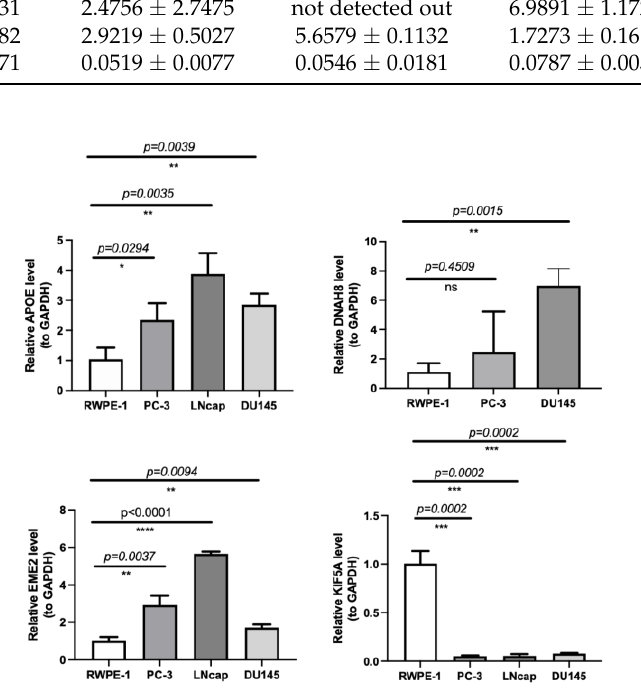
Figure 7. mRNA expression levels of the four model genes in human normal prostate epithelial cells (RWPE-1) and PCa cells (PC-3, LNcap, and DU145). * p < 0.05, ** p < 0.01, *** p < 0.001, **** p < 0.0001, ns represents no significant difference.